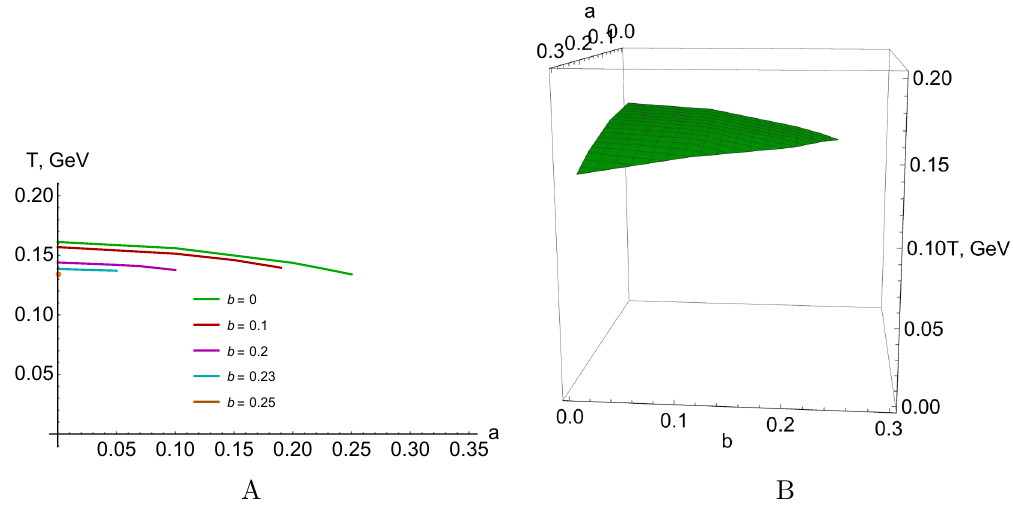
Figure 6 . Locations of the first order phase transition in terms of a and b . A) Locations of the end points for fixed b are indicated by dots. We see that all end points have the same temperature T CEP = 0 . 134 GeV. B) The location of the phase transition T cr = T cr ( a 2 , b 2 ) is shown by the green